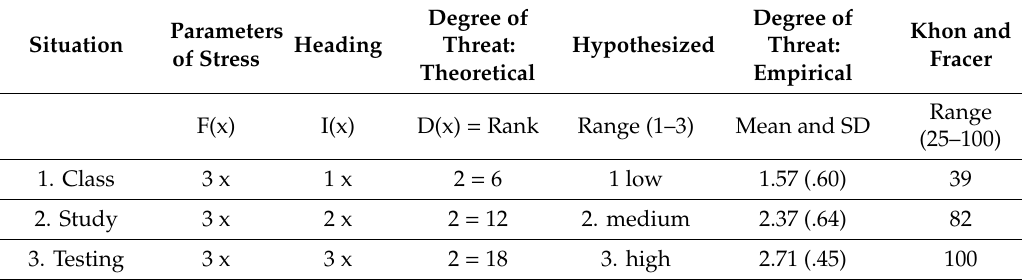
Table 1. Level of threat perceived in academic